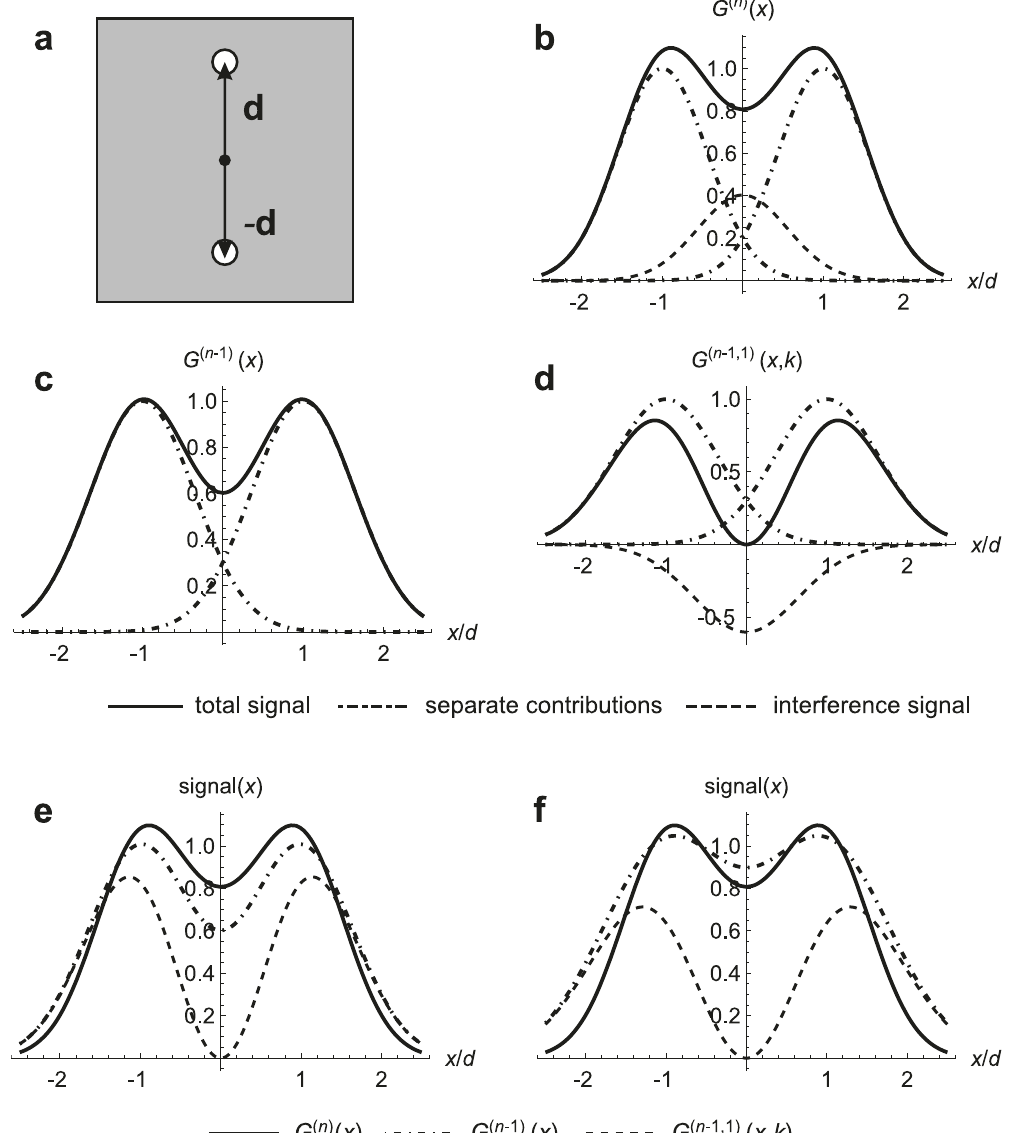
Fig. 2 Model example. Imaging two pinholes ( a ), separated by the distance 2 d , with the n -photon entangled state of light. The n -photon coincidence detection leads to constructive interference of the light passing through the pinholes ( b ). The interference is absent for ( n − 1)- photon detection ( c ). For a particular value of the transverse momentum of one of the entangled photons, the conditional detection of the remaining n − 1 photons may exhibit destructive interference ( d ). Dot-dashed lines represent separate contributions from the pinholes; the dashed line shows the interference signal; the solid line represents the sum of all the contributions. For the simulations, we used the PSF h ð s ; r Þ / exp ½(cid:2)ð s (cid:2) r Þ 2 = ð 5 d 2 Þ(cid:4) and n = 4. Note, that the peaks in panels c and d are n /( n − 1) = 4/3 times wider than in panels b , but the image contrast is better due to the absence of constructive interference. Panel e summarizes the results, showing the total signals from panels b , c , and d for their comparison: G ( n ) ( x ) (solid line), G ( n − 1) ( x ) (dot-dashed line), and G ( n − 1,1) ( x ) (dashed line). Panel f shows the same signals for n = 2 and PSF h ð s ; r Þ / exp ½(cid:2)ð s (cid:2) r Þ 2 = ð 2 : 5 d 2 Þ(cid:4) with its width ensuring the same image contrast for the n th order correlations (shown by the solid line) as in previous panels. As expected for n = 2, G ( n − 1) ( x ) does not outperform G ( n ) ( x ) in terms of the image